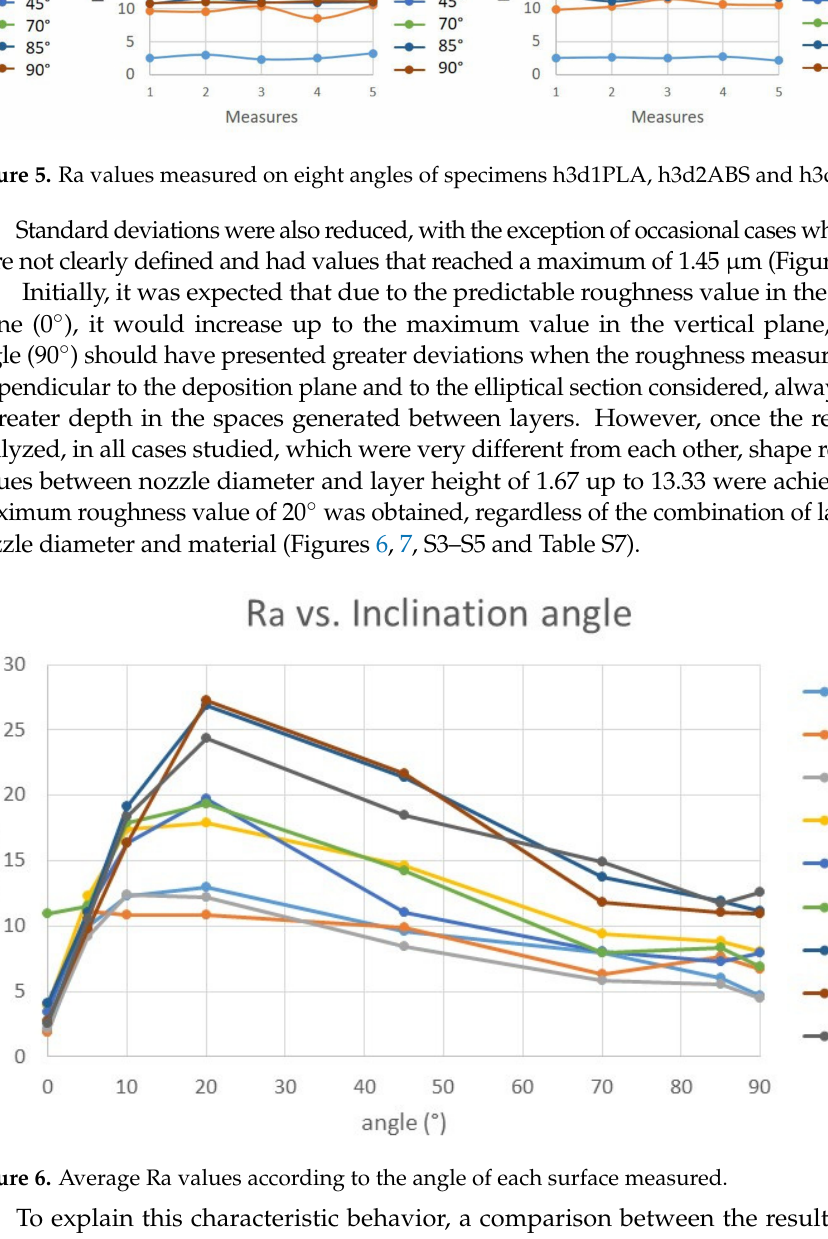
Figure 7. Average Ra, Rq and Rz values for the ABS material. To explain this characteristic behavior, a comparison between the results from the rugosimeter and the theoretical values was drawn. Figure 8 shows the profile obtained from the rugosimeter measurement (blue color), with a section in the zone below the fig- ure marked in red to represent the theoretical distribution for 5° (the downward inclina- tion of the filament deposited).